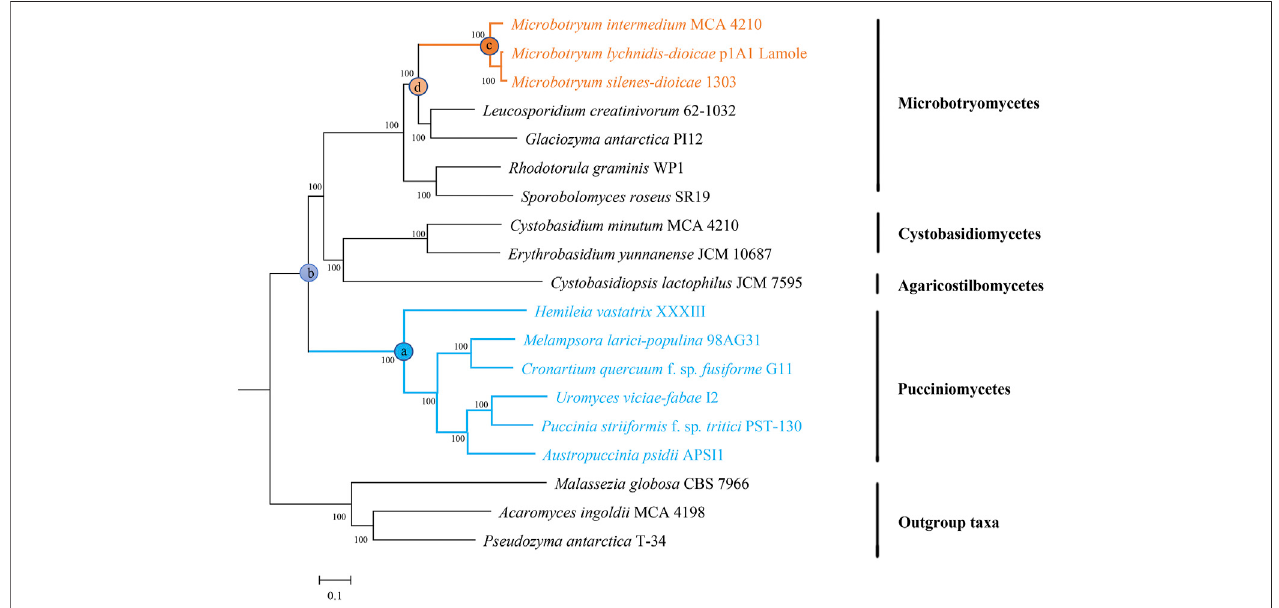
FIGURE 2 | Genome-wide phylogenetic tree of 19 selected fungi. All single-copy genes were used to infer the phylogenomic tree topology using RAxML-NG. Numbers near the nodes are bootstrap support values. Anther smuts and rust fungi are indicated in orange and blue, respectively.